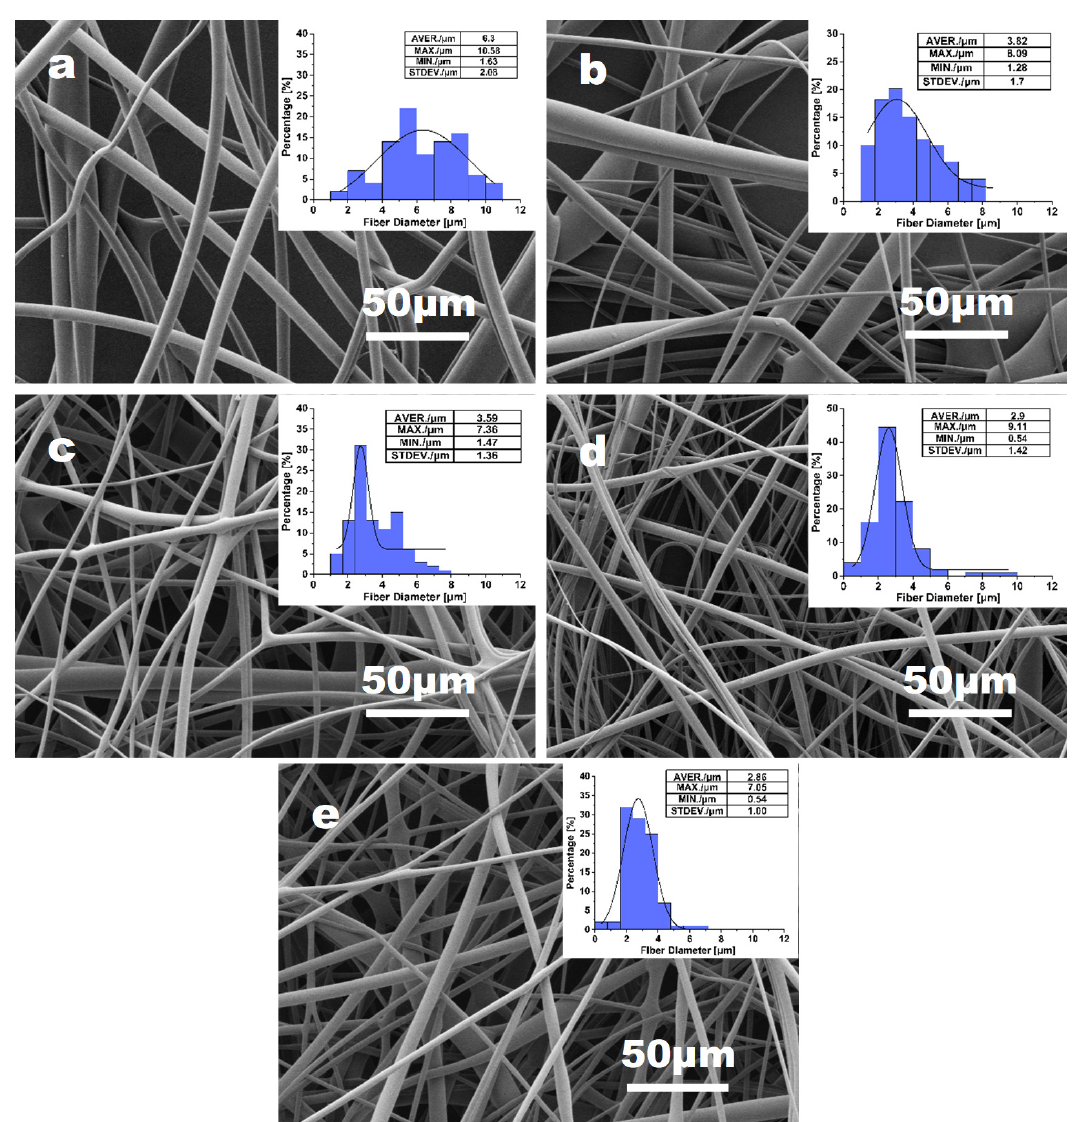
Figure 9. The effect of different voltages: ( a ) 8 kV; ( b ) 12 kV; ( c ) 16 kV; ( d ) 20 kV; ( e ) 24 kV on 15% PVA fiber morphology and fiber diameter distribution, with fixed parameters of 22# (0.51 mm diameter) nozzle size, rotation speed = 5500 rpm and feeding rate = 3000 mL h − 1 .